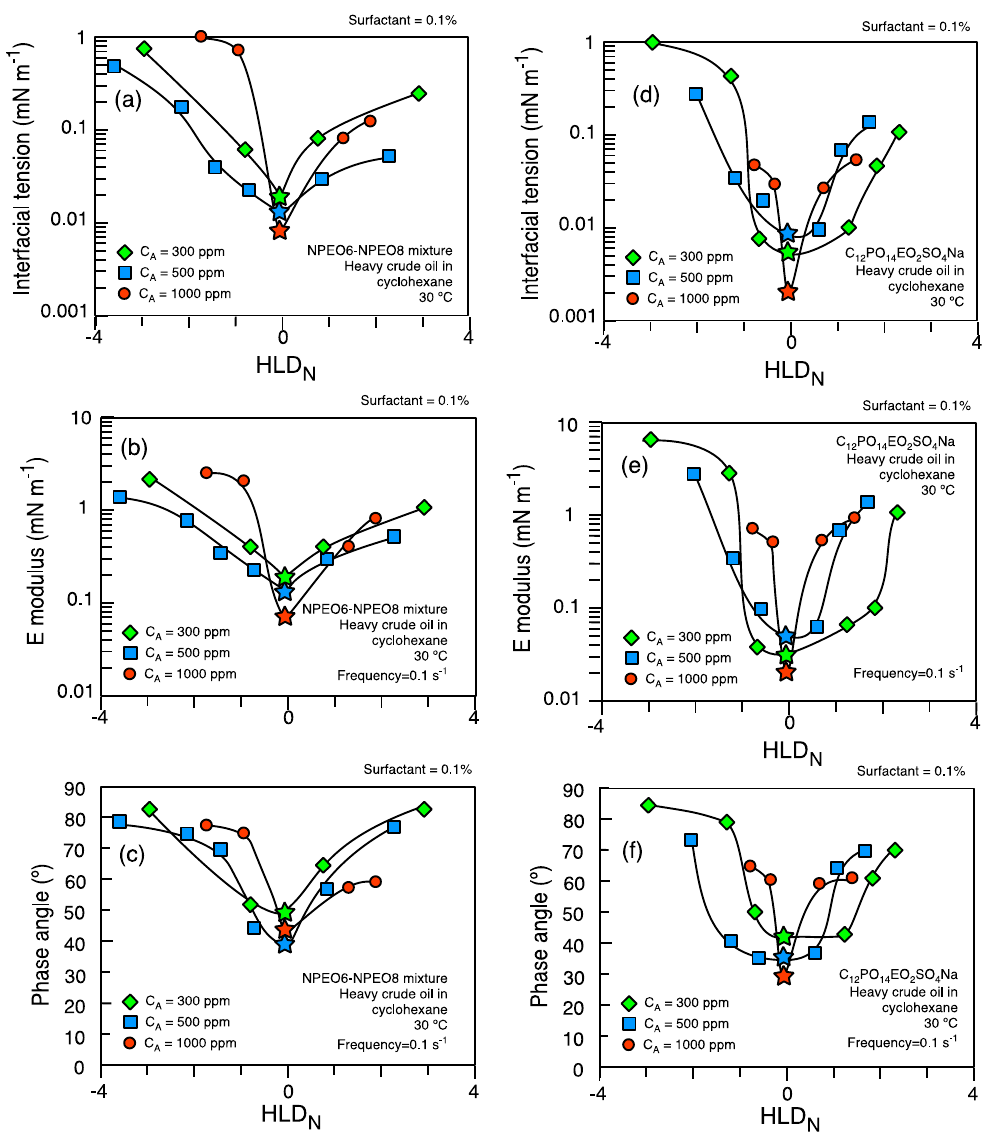
Figure 12. Interfacial tension, dilational elasticity and phase angle for a heavy crude oil diluted in cyclohexane/surfactant 0.1%/brine system. Nonionic surfactant: ( a – c ) NEOP6-NPEO8 mixture (EON scan), and anionic extended surfactant (salinity scan) ( d – f ) C 12 PO 14 EO 2 SO 4 Na were used.